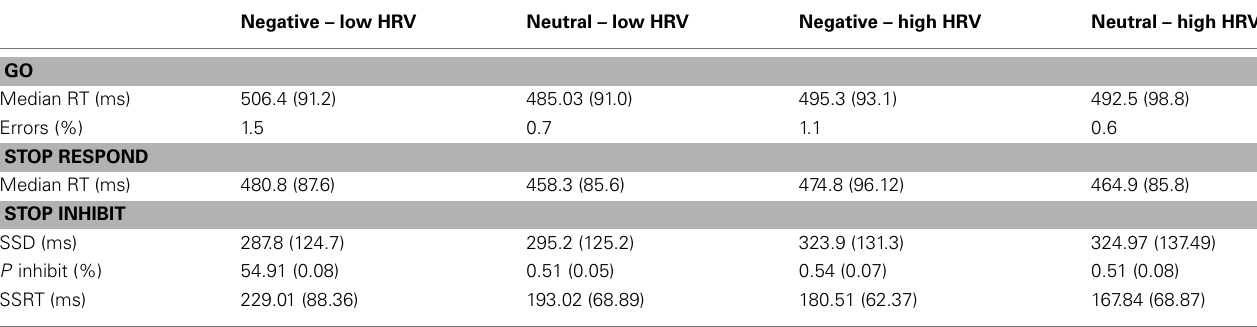
Table 3 | Behavioral data during the emotional stop task on Go and Stop